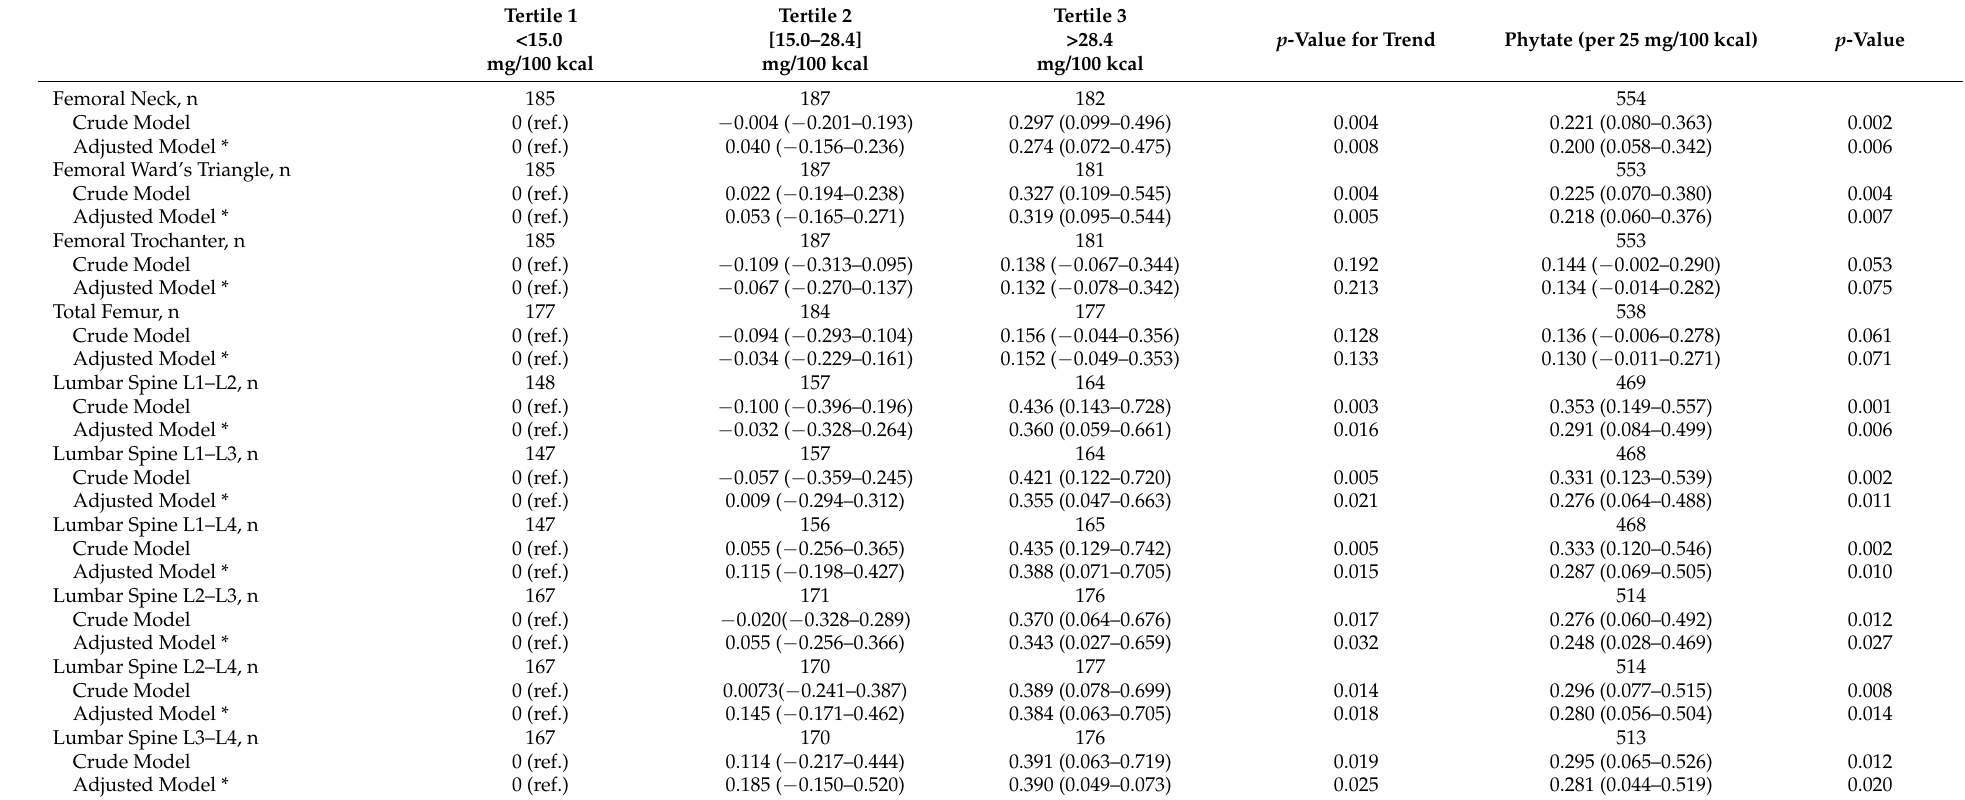
Linear regression models were used to evaluate the association between T-scores and estimated phytate intake (tertiles and per each 25 mg/100 kcal). Results are expressed as β coefficients (95% CIs). * Models adjusted for age (years), BMI (kg/m 2 ), physical activity (MET • min/week), educational level (higher education/technician or secondary